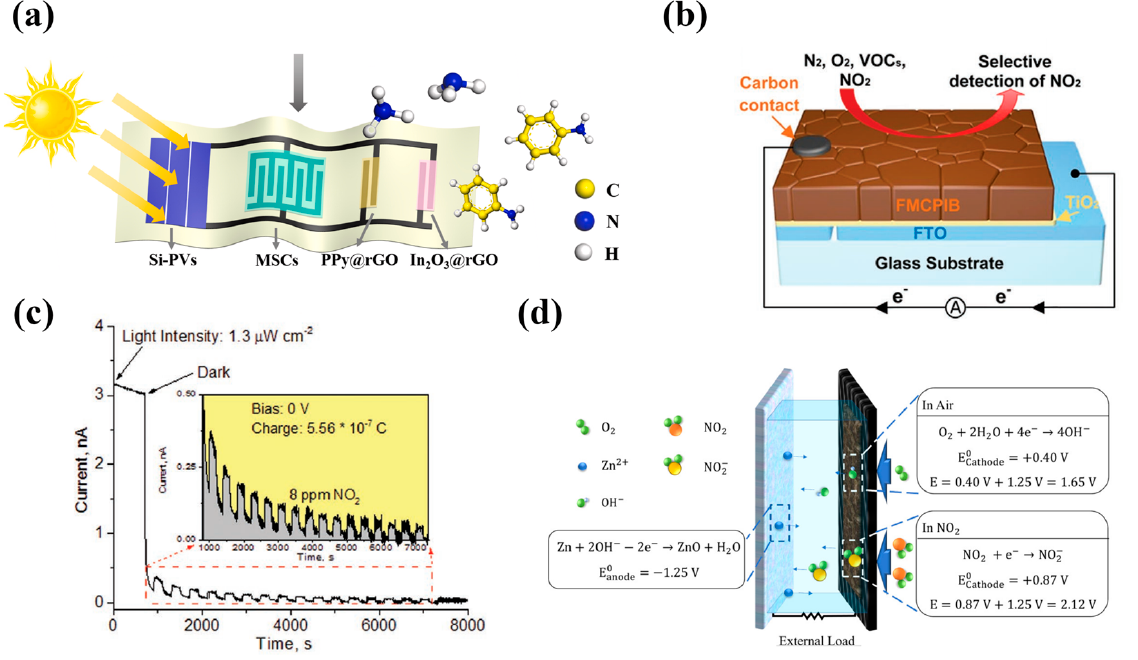
Figure 7. ( a ) Schematic of seamlessly integrated solar cell, micro-supercapacitor, and gas sensor on a flexible substrate. Reprinted with permission from Ref. [119]. Copyright 2021, Nano energy. ( b ) The schematic of perovskite-based device and its ( c ) dynamic current response under irradiation and darkness. Reprinted with permission from Ref. [126]. Copyright 2020, Advanced Optical Mate- rials. ( d ) Key reactions and mechanisms of battery–sensor hybrid device. Reprinted with permission from Ref. [127]. Copyright 2021, ACS Applied Materials & Interfaces. Biosensors: Biosensors can minimally and non-invasively detect various biological media (blood, sweat, urine, etc.) to obtain physiological information, such as blood glu- cose level, pH, [Na + ] and [K + ] content, etc. As mobile devices become ubiquitous, wearable integrated systems of energy-storage devices and biosensors provide a broad platform for personalized healthcare and will release the pressure of clinical resources in the future [110,111,128]. Several representative energy-storage devices integrated biosensing sys- tems for sweat, interstitial fluid (ISF), and blood detection will be summarized below. Shen et al. [129] integrated multiple micro-supercapacitors and sensors for detecting glucose, [Na + ], and [K + ] contents in human sweat on a single Poly (ethylene terephthalate) (PET) substrate (Figure 8a). The NiCo 2 O 4 -based micro-supercapacitors exhibited a high energy density of 0.64 μ W cm − 2 at the power density of 0.09 mW cm − 2 . Furthermore, the integrated system displayed excellent sweat detection performance with high sensitivities of 0.5 μ A/ μ M for glucose, 0.031 nF/mM for [Na + ], and 0.056 nF/mM for [K + ]. In addition, it can be further integrated with wireless transmission technology, and realized with a real-time wireless detection of about 2 h though connecting with a smartphone. However, when no sweat is produced, special switch control is required to avoid invalid operation of the system. Yu et al. [130] reported a novel flexible sweat-activated battery (FSAB) with graphene/Ni foam and a Mg sheet as electrodes, respectively (Figure 8b), which provided a new idea to solve this problem. Once sweat was generated, it would be absorbed and diffused immediately by the bottom cotton layer of the battery, and the battery was then activated within 30 s. The FSAB exhibited a high energy capacity of 74.4 mA h and a power density of and 16.3 mW cm − 2 , which can power 120 LEDs for 4 h. In addition, they further developed a FSAB-integrated multiple sensing system for wireless and continuous phys- iological monitoring, including exercising intensity, skin temperature, pulse rate, and ox- ygen saturation in blood. However, these two systems are just embryonic forms, and their wearability is low due to the lack of appropriate packaging for their components. Ye et al. [131] developed a flexible hydrogel–paper patch, which could serve as low-impedance ECG electrodes due to the high conductivity, and the hydrophilic wettability endowed it with glucose-sensing performance (after the deposition of Pt nanoparticle), as shown in